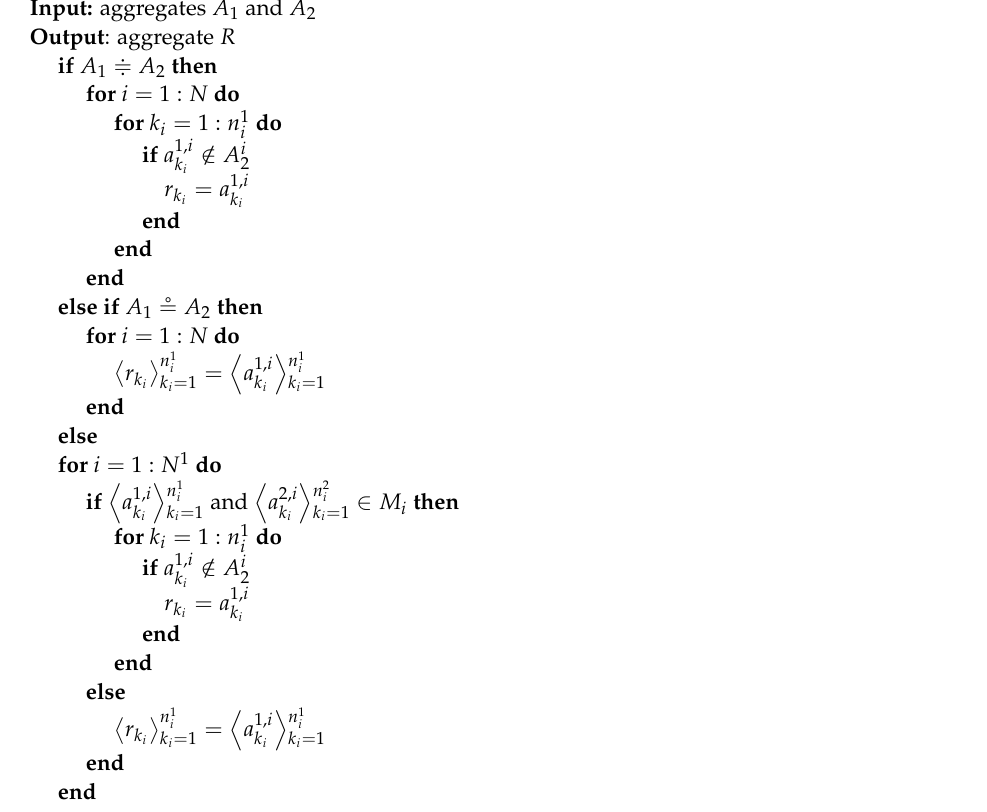
( a ) The given compatible aggregates.